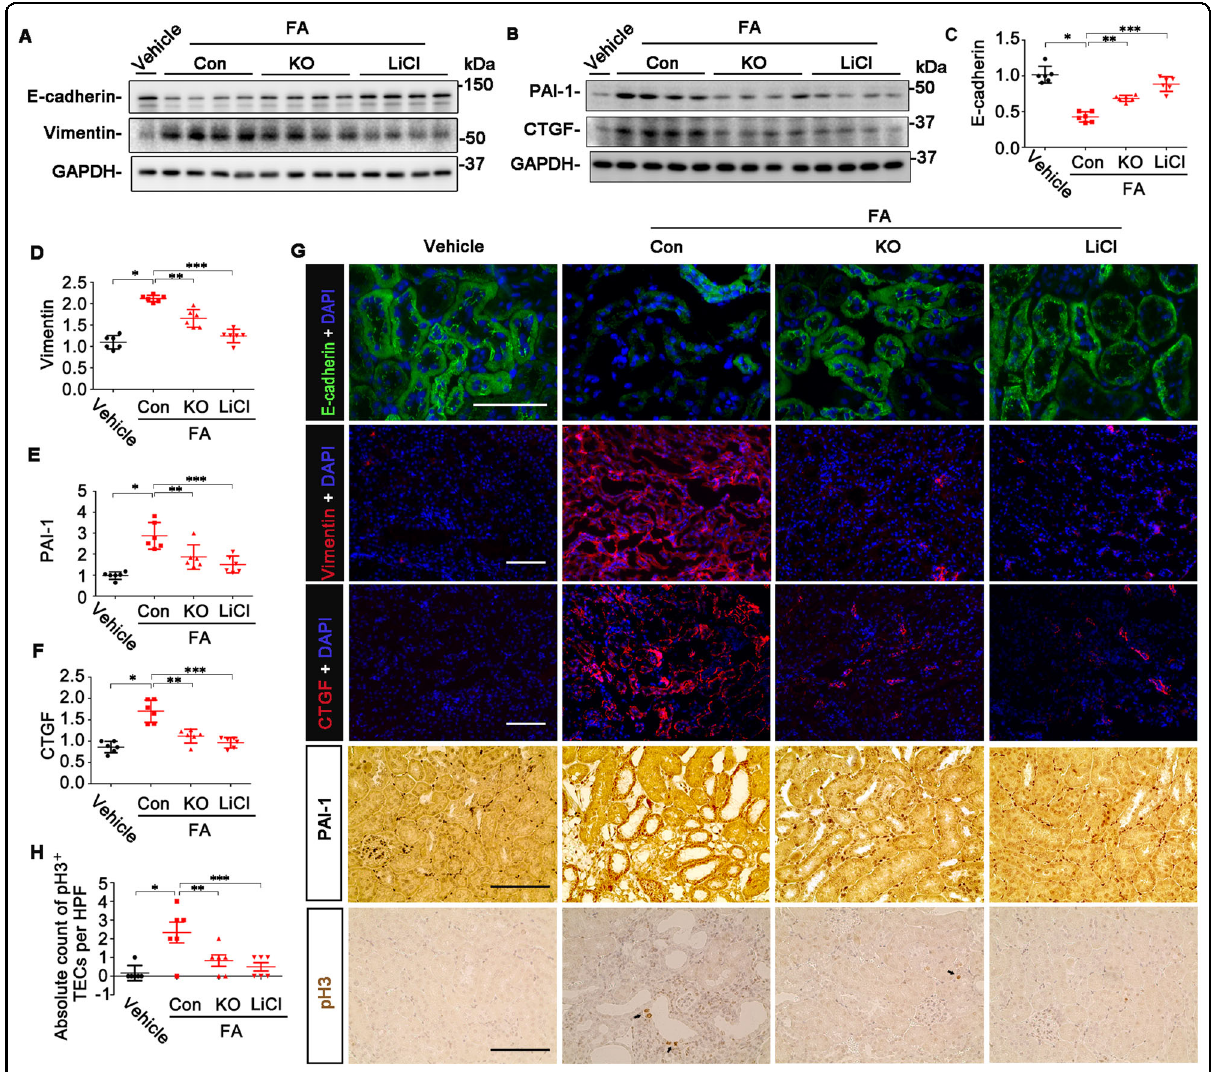
Fig. 7 Pro fi brogenic plasticity of renal tubules in the mouse model of FA nephropathy is abrogated by TEC-speci fi c GSK3 β ablation or by lithium. A , B Kidney homogenates were processed for immunoblot analysis for E-cadherin, vimentin, PAI-1, CTGF, and GAPDH. Representative immunoblots were shown. C – F Densitometric analyses of the expression levels of E-cadherin, vimentin, PAI-1, and CTGF, as normalized to the GAPDH expression and expressed as fold changes relative to the control group. *P, **P, ***P < 0.05 ( n = 6, ANOVA followed by Tukey ’ s test). G Representative micrographs of immuno fl uorescence staining for E-cadherin (green), vimentin (red), and CTGF (red) with nuclear counterstaining with DAPI (blue), or peroxidase immunohistochemistry staining for PAI-1 and pH3 in kidney tissues. Scale bar = 100 μ m. H Absolute counting of the number of TEC cells positive for pH3 staining per high power fi eld (HPF). * P , ** P , *** P < 0.05 ( n = 6, ANOVA followed by Tukey ’ s